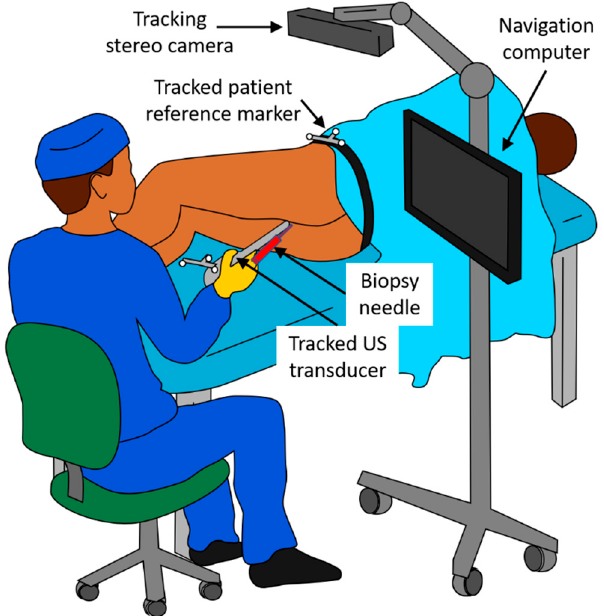
Figure 1. Physical layout of the NaviPBx prostate biopsy system, as envisioned.